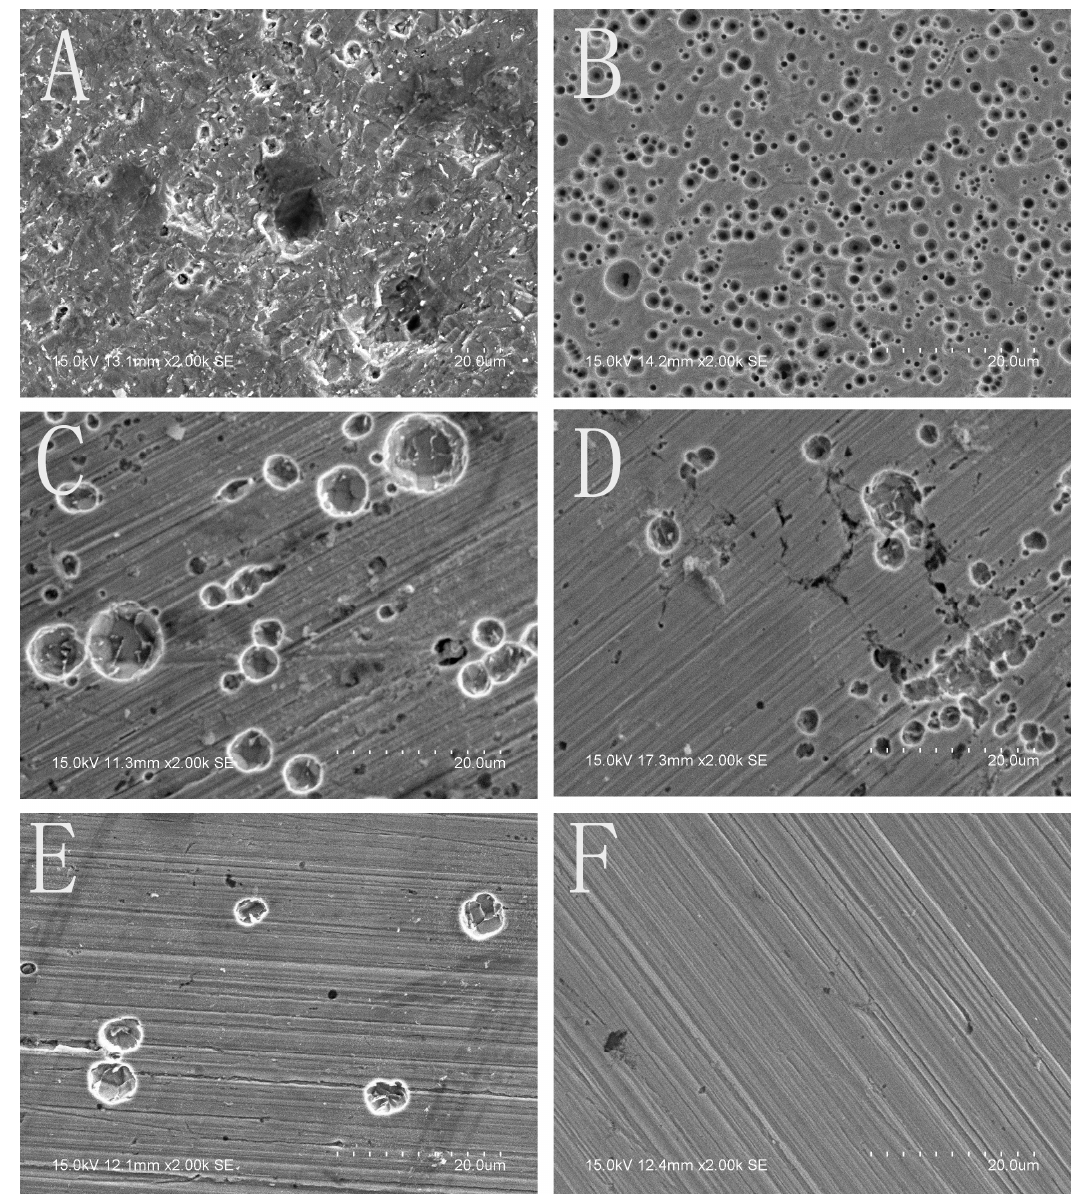
Figure 4. The surface morphology of the X70 carbon steel electrodes after the polarization in various solutions ( A ) after 30 min polarization in 0.10 mol/L NaCl solution at − 0.320 V ( E OCP = − 0.570 V); ( B ) after 50 min polarization in (0.10 mol/L NaCl + 0.010 mol/L NaOH) solution at − 0.300 V ( E OCP = − 0.550 V); ( C – F ) after 50 min polarization in (0.10 mol/L NaCl + x mol/L Na 3 PO 4 ) solutions at − 0.290 V ( E OCP = − 0.540 V) ( C : x = 0.020; D : x = 0.040; E : x = 0.060; F : x = 0.080).